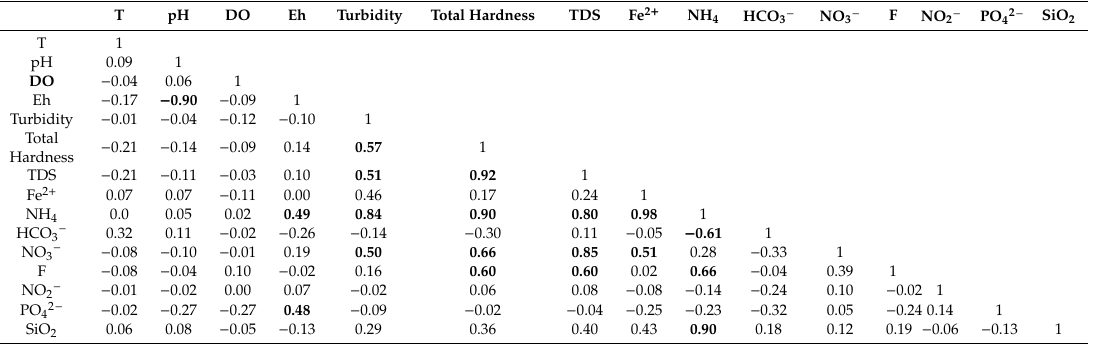
Table 2. Pearson’s correlation coe ffi cients among the studied quality